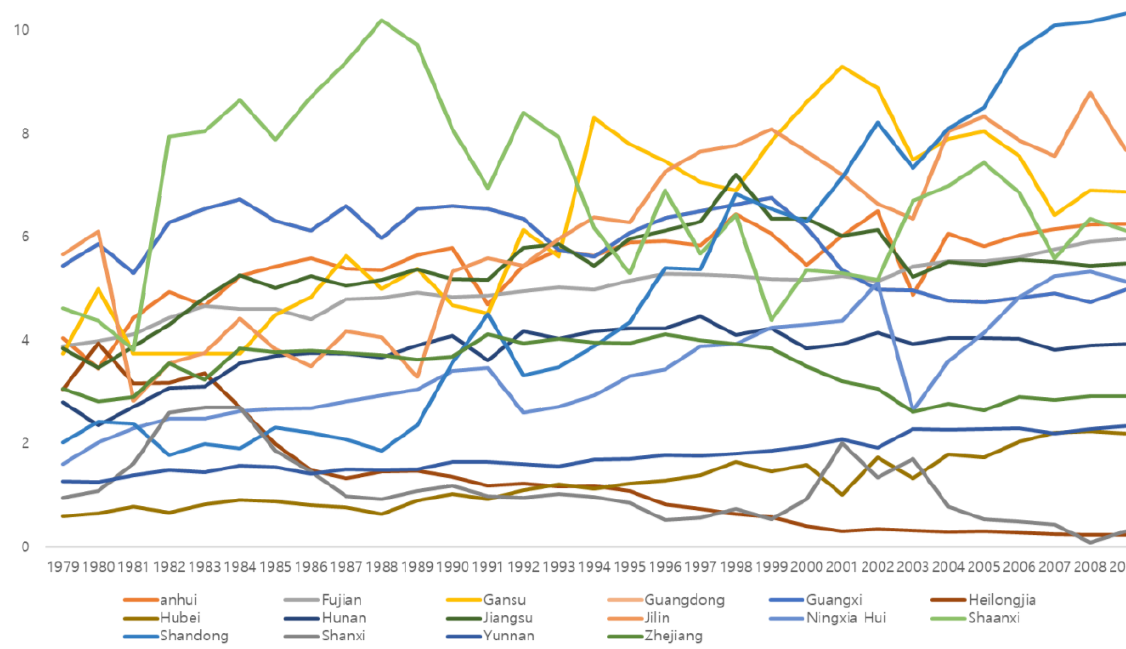
Figure 2. Rice yield variation of 16 provinces in China